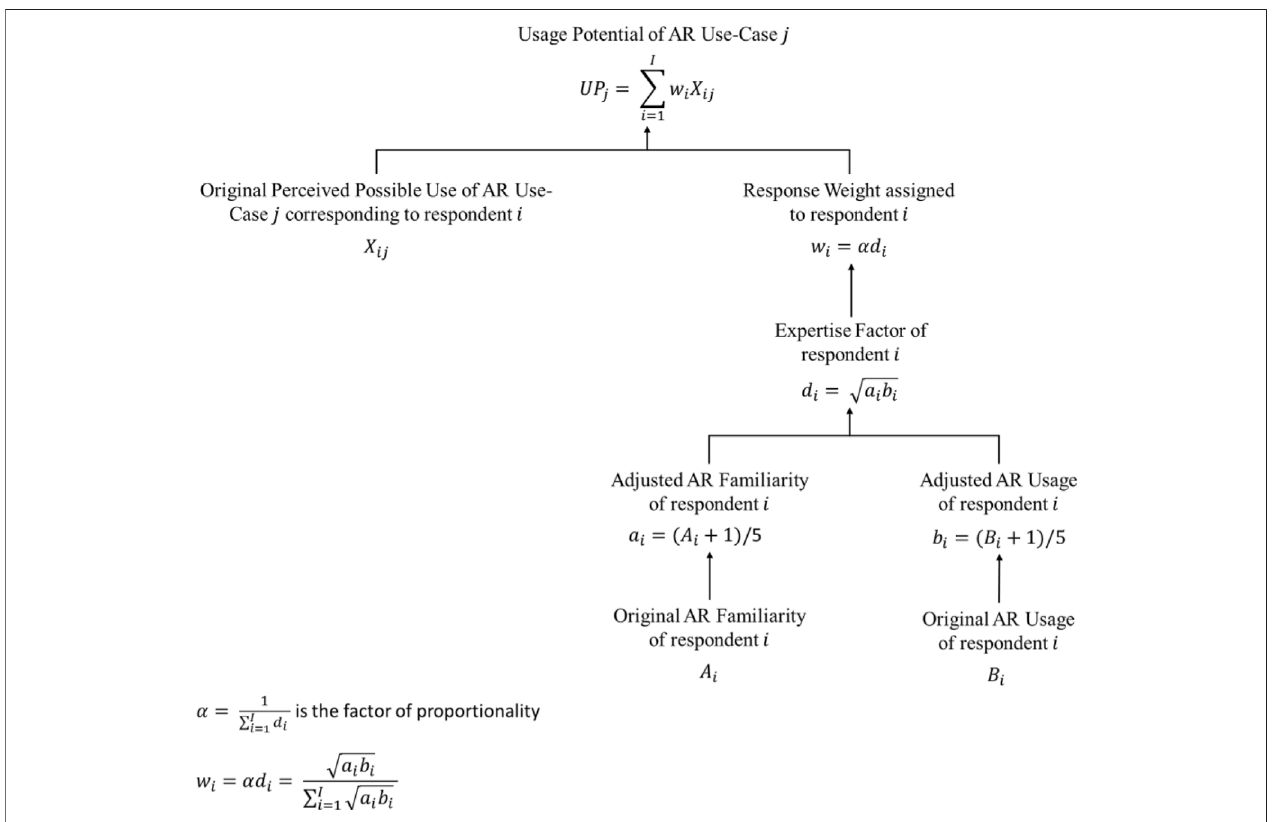
FIGURE 4 | Flowchart of the mathematical